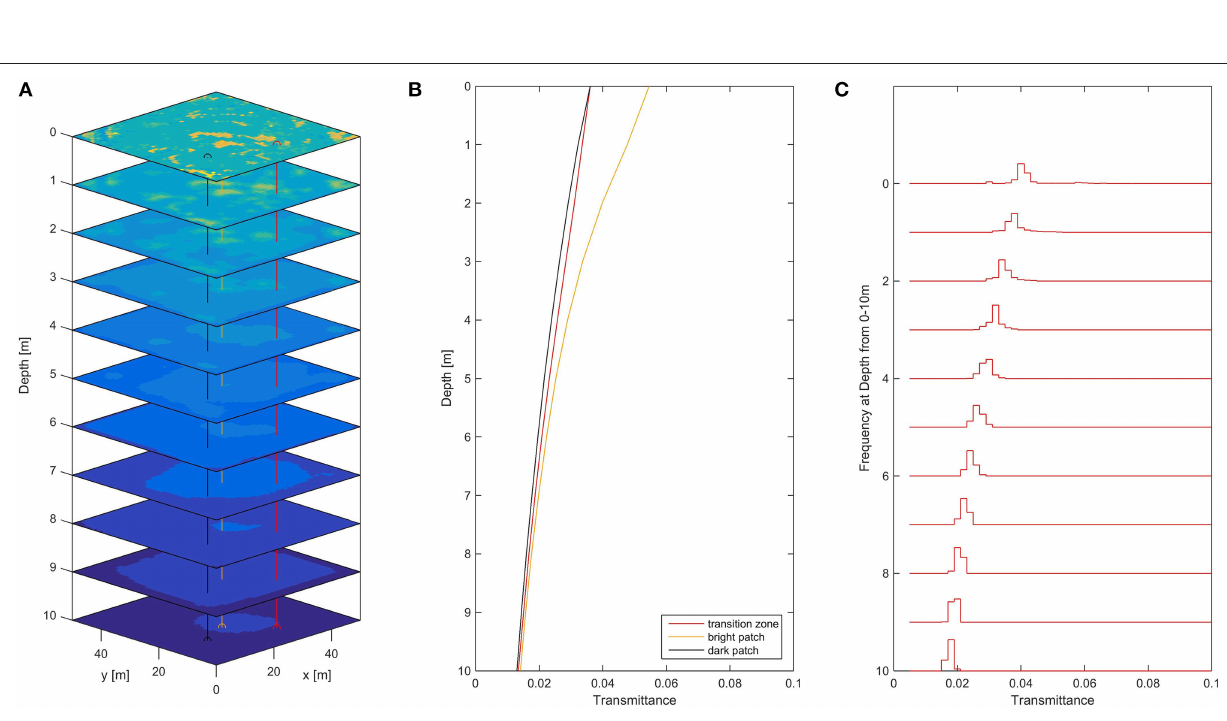
Frontiers in Earth Science |